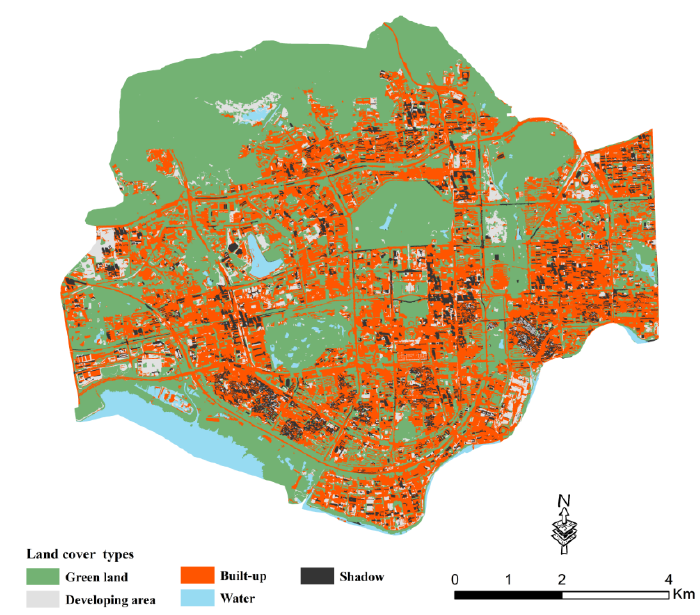
Figure 4. Land cover map derived from GF-2 image using object-based image classification.